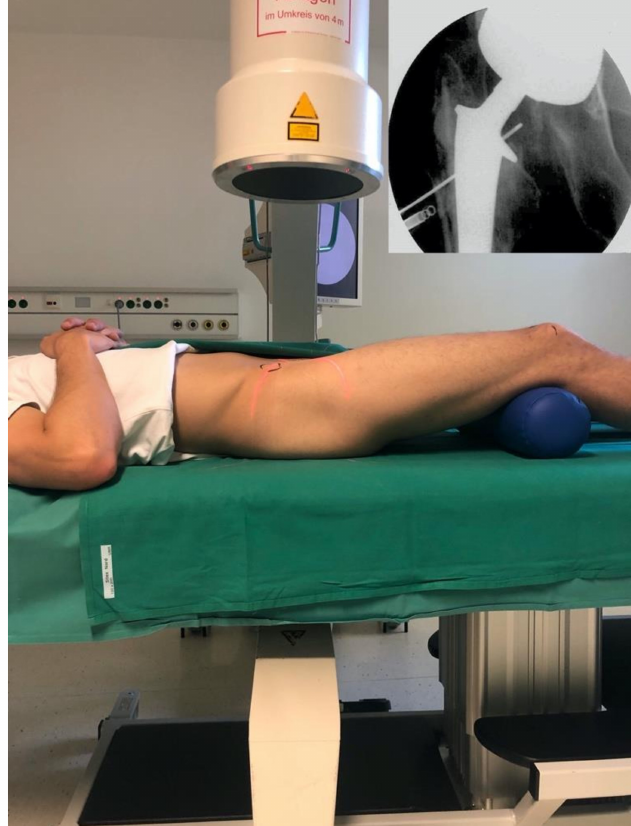
Figure 1. Position the patient for puncture of the hip joint. Spina iliaca anterior superior and middle of the patella are marked in black as corner points of the safe zone. Hip in 20 ◦